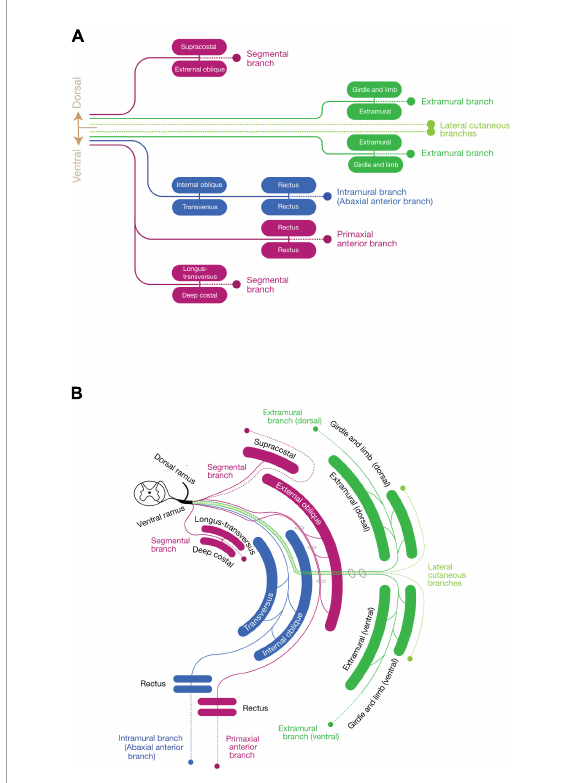
FIGURE7 Schematic depiction of the three components mapped to the muscle classes. (A) Map of the three nerve components to muscle classes. Primaxial muscle-innervating branches (purple) include the dorsal segmental branches to the supracostal and external oblique, the ventral segmental branches to the longus-transversus and deep costal muscles classes, and the primaxial anterior branch to the primaxial rectus class. The LCB (light green) also consists of a pair of the dorsal and ventral subbranches, accompanying the dorsal and ventral extramural branches (dark green) to the girdle and limb muscle classes. The intramural branch (blue) innervates the internal oblique, transversus, and rectus muscle classes, and no dorsal counterpart exists. (B) Diagram with the layer information. The terminal branches of the three-components run in different inter-muscular spaces: the primaxial anterior branch in the superficial inter-muscular space, the intramural branch in the deep inter-muscular space, and the extramural branch in the outside of the body wall. A basic building unit is created from the innervation pattern of the dorsal rami to the four subclasses of the intrinsic back muscles; one main branch sends muscle-innervating twigs to a parallel pair of muscles, and ends as one terminal sensory branch (broken lines). Note that the body wall is composed of the eight muscle